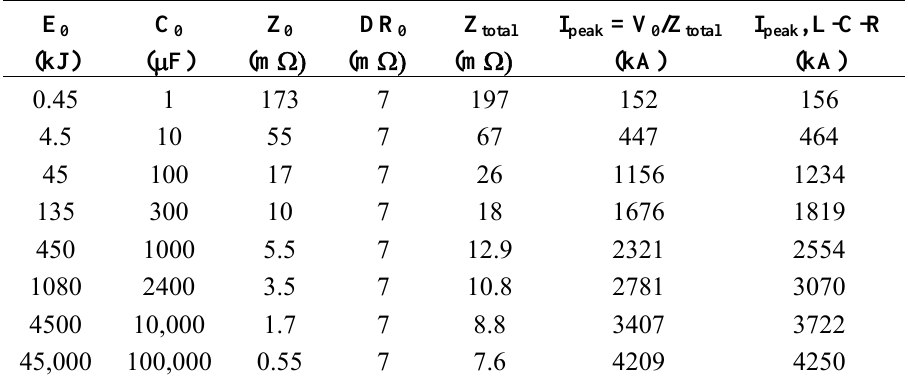
‘saturation’ at large E peak